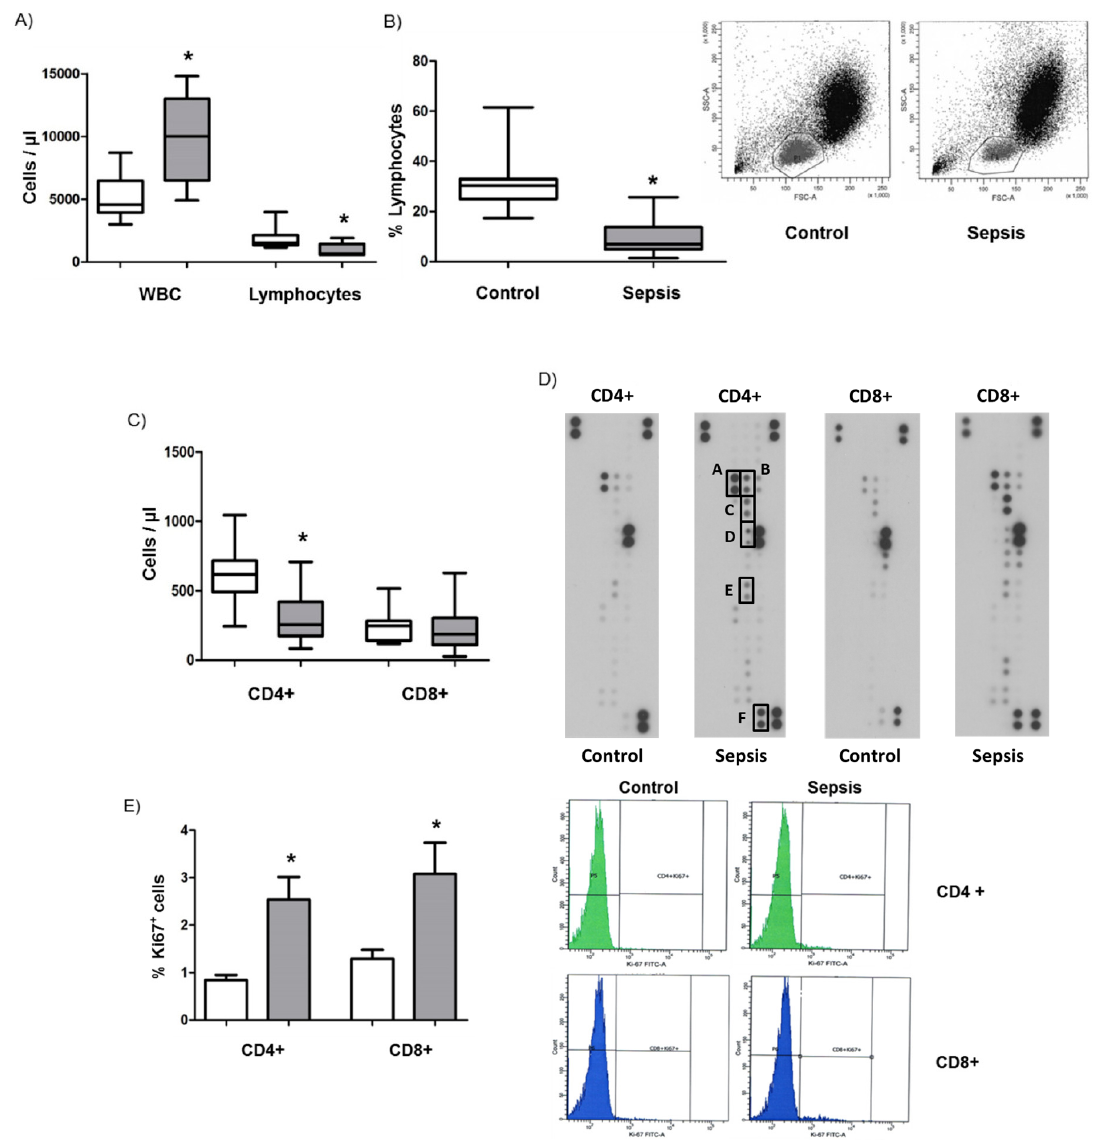
Figure 1. Lymphopenia, apoptosis, and proliferation in sepsis patients and control patients. ( A ) Cell counts of white blood cells (WBC) and lymphocytes in healthy controls (white bars) and sepsis patients (grey bars). ( B ) Percentage of lymphocytes in the peripheral blood of controls and sepsis patients. ( C ) Absolute numbers of CD4+ and CD8+ lymphocytes in the blood of controls (white bars) and sepsis patients (grey bars) assessed by magnetic cell sorting and counting. ( D ) Apoptosis protein array of CD4+ and CD8+ cells (homogenate) derived from controls and sepsis patients. The letters A-F indicate regulated proteins (A: p27/Kip1; B: Fas-associated protein with death domain (FADD); C: Fas; D: Hypoxia-inducible factor (HIF)-1 α ; E: Heme oxygenase 2 (HMOX); F: Livin). The assay was performed one time with pooled samples. ( E ) Proliferation of CD4+ and CD8+ lymphocytes assessed by Ki67 staining (white bars: control; grey bars: sepsis) with representative flow cytometric charts. Data are displayed as a box-and-whisker plot representing the 25th and 75th percentiles (bottom and top of the box), the median (band inside the box), and the minimum and maximum of all data (ends of the whiskers) for ( A – C ). Data are displayed as mean ± SEM for ( E ) Asterisks (*) denote statistical significance, with p < 0.05.